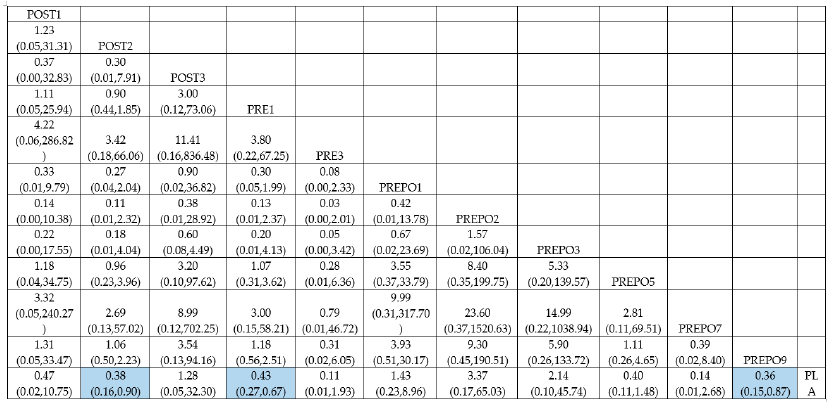
Figure 4. League table for implant failure (per patient).